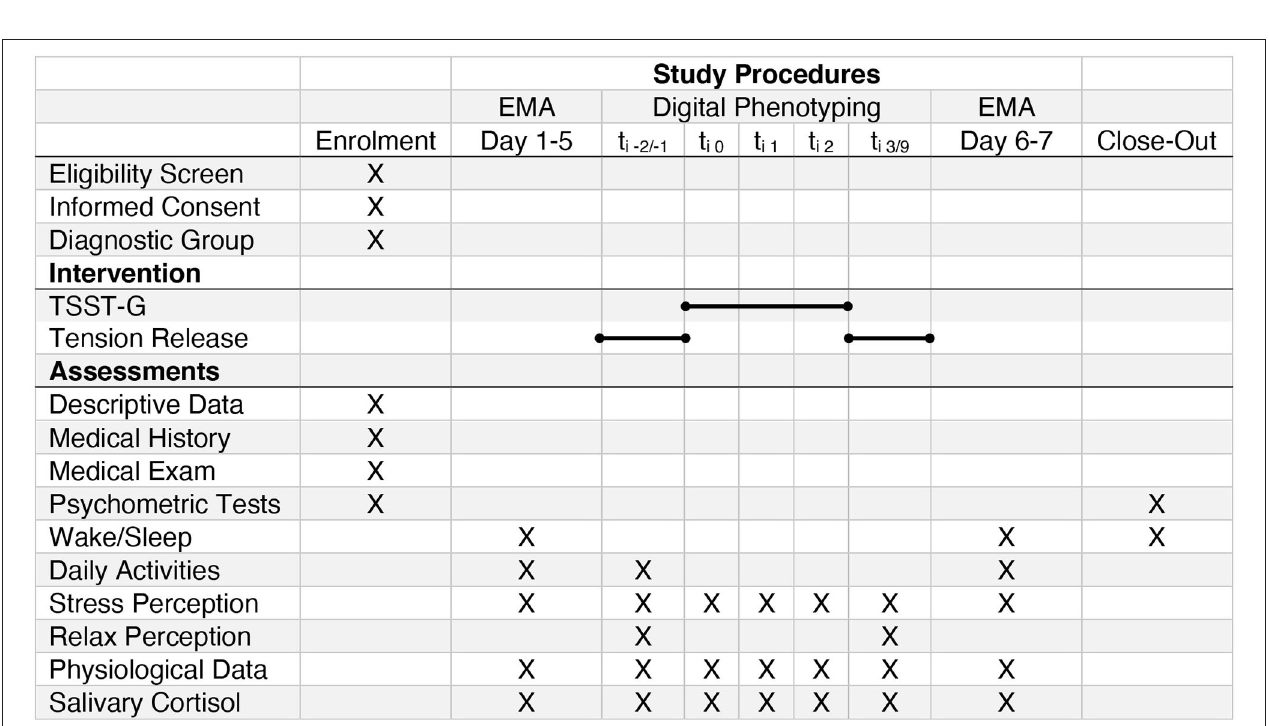
FIGURE 1 | Study Outline. The initial and final evaluations (green) include a psychological test battery and the collection of cortisol samples. Well-being and basal cortisol levels are assessed daily at fixed time frames (only morning and night assessment shown). During the TSST-G (blue) DP, stress and cortisol levels are conducted. Coincidentally experienced challenging of stressful situations/events (red) are assessed shortly after they occur (shown for illustrative purposes only). Physiological parameters are continuously assessed through wearable devices.